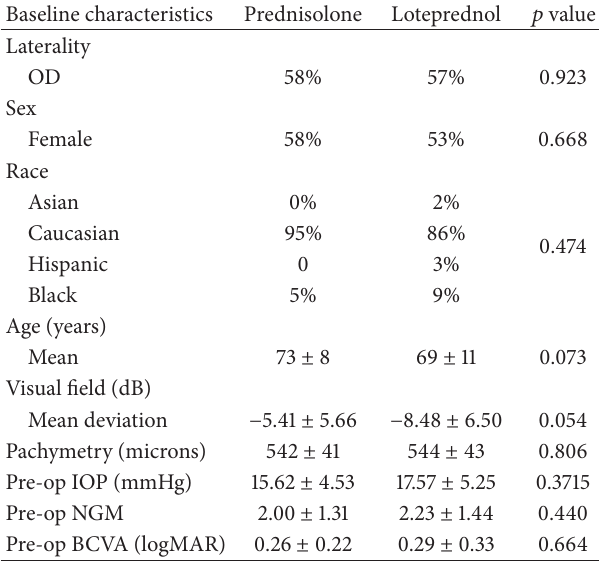
Table 1: Preoperative clinical and demographic